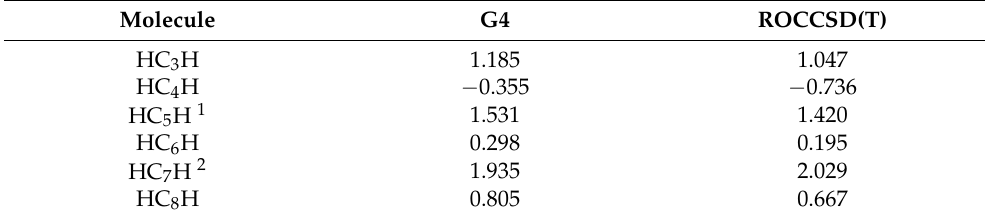
Table 2. Adiabatic electron attachment energies EA computed using the G4 composite model and via ROCCSD(T) at the B3LYP/6-311++G(3df,3pd) minima. Values in eV. Notice that except for HC 4 H – , all the other HC n H – listed possess positive EAs and are therefore stable against electron detachment.